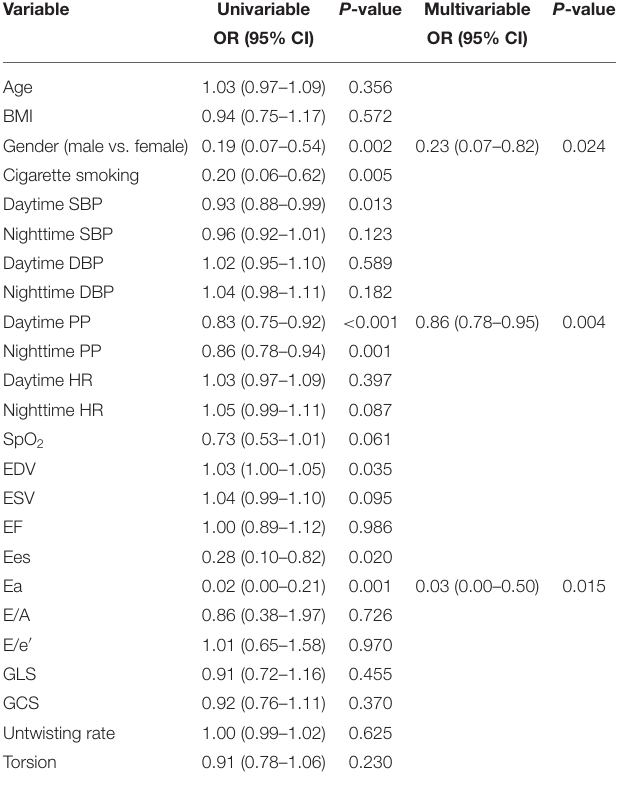
TABLE 3 | Risk factors of AMS.